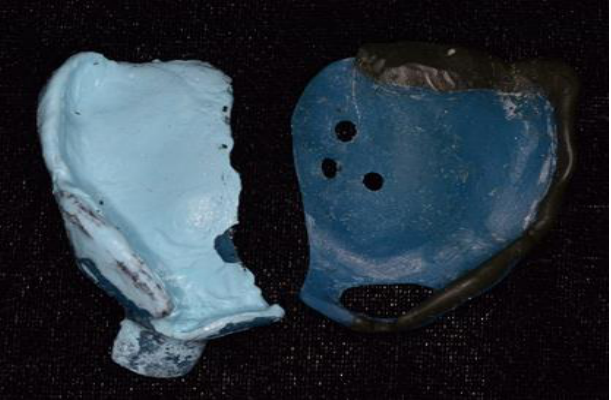
Fig. 4A. Maxillary taking impression